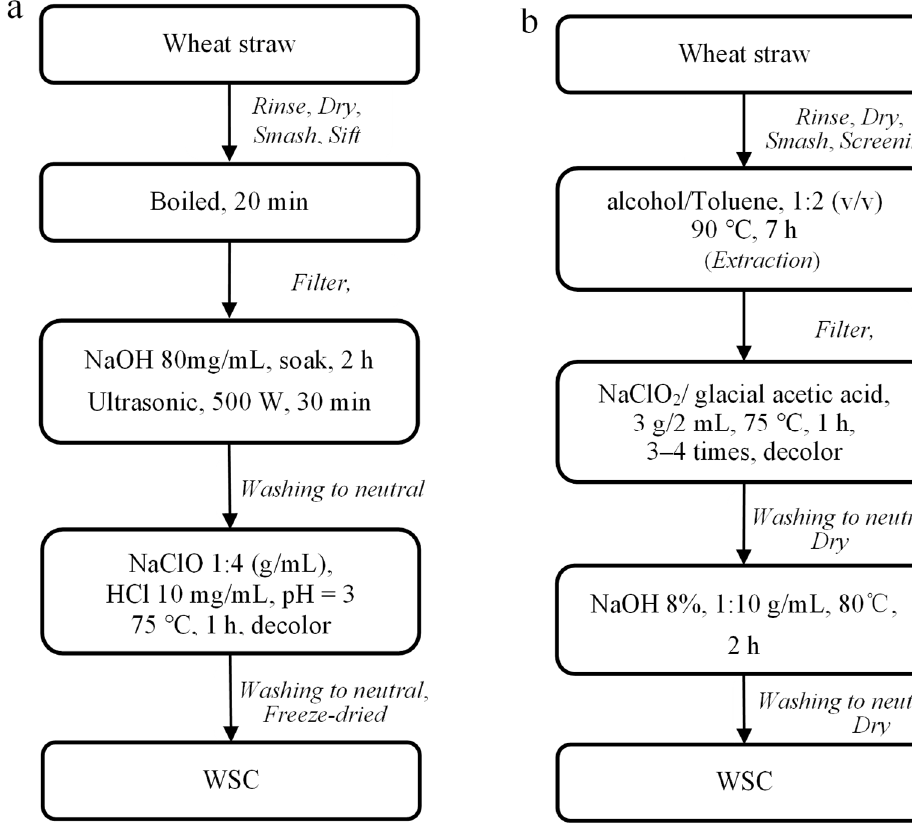
Figure 1. Flowchart of WSC preparation method: ( a ) AM; ( b )